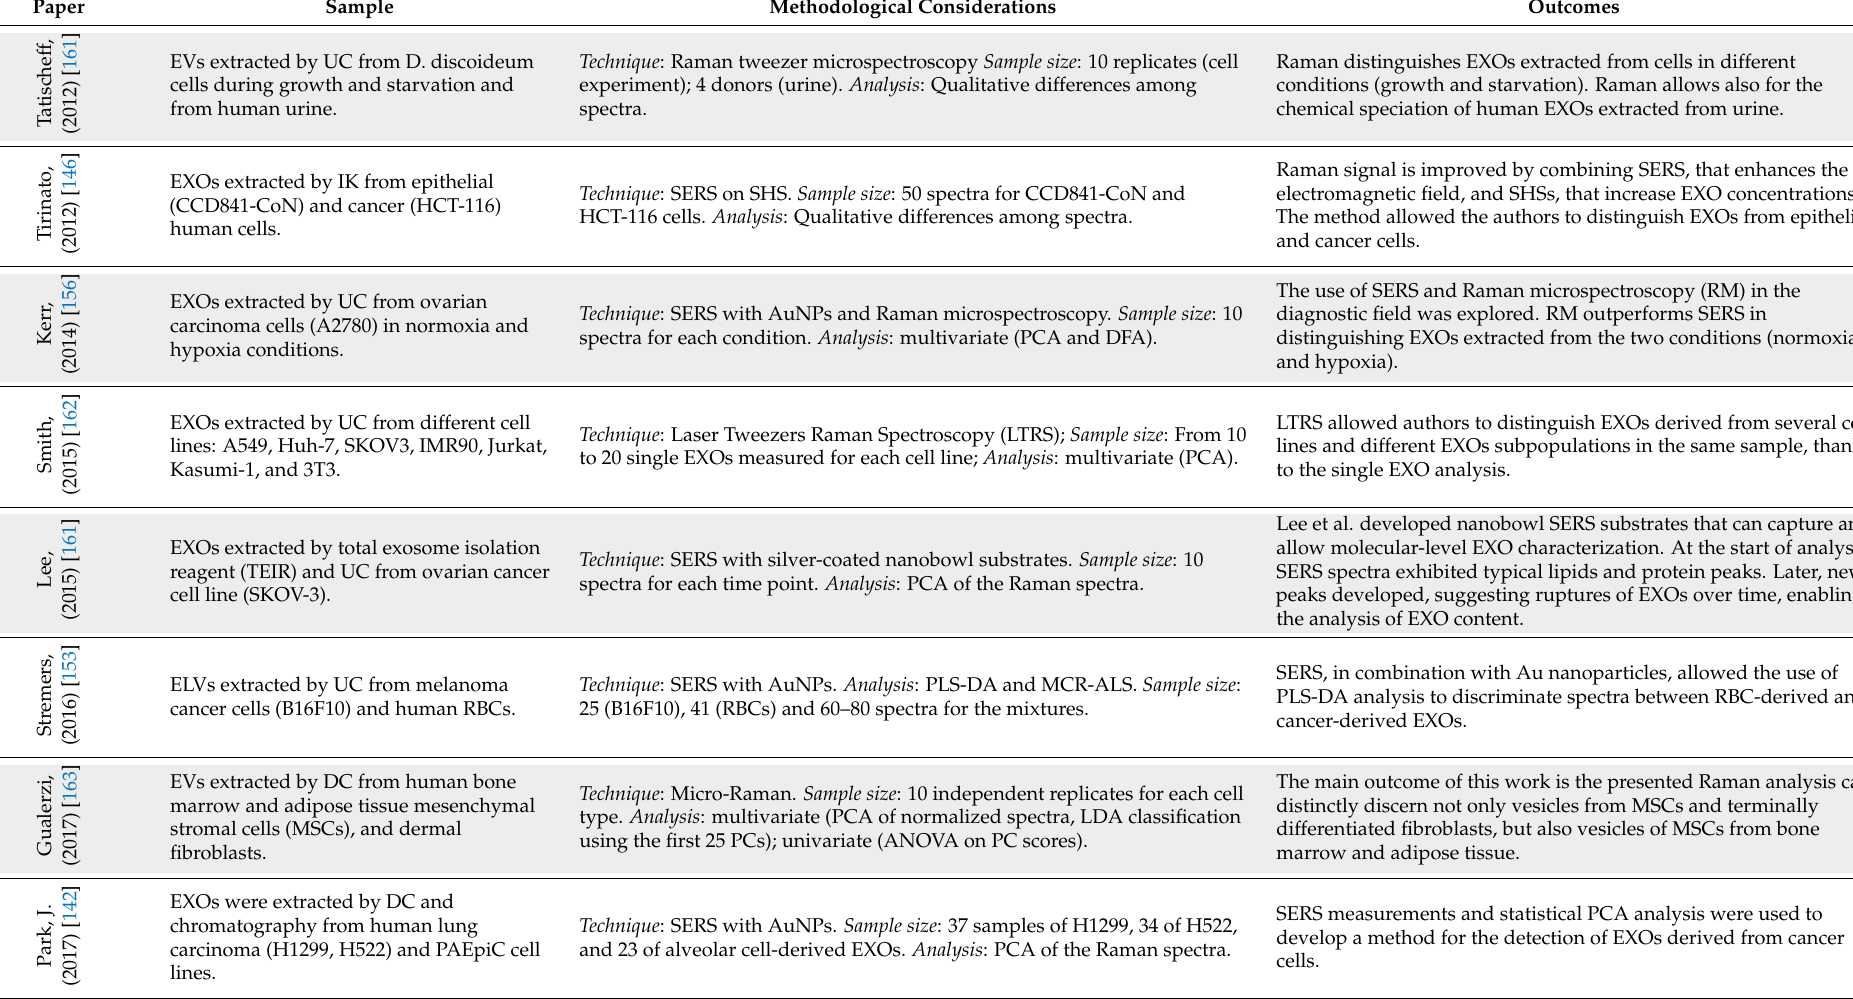
Technique : SERS with AuNPs. Sample size : 37 samples of H1299, 34 of H522, and 23 of alveolar cell-derived EXOs. Analysis : PCA of the Raman